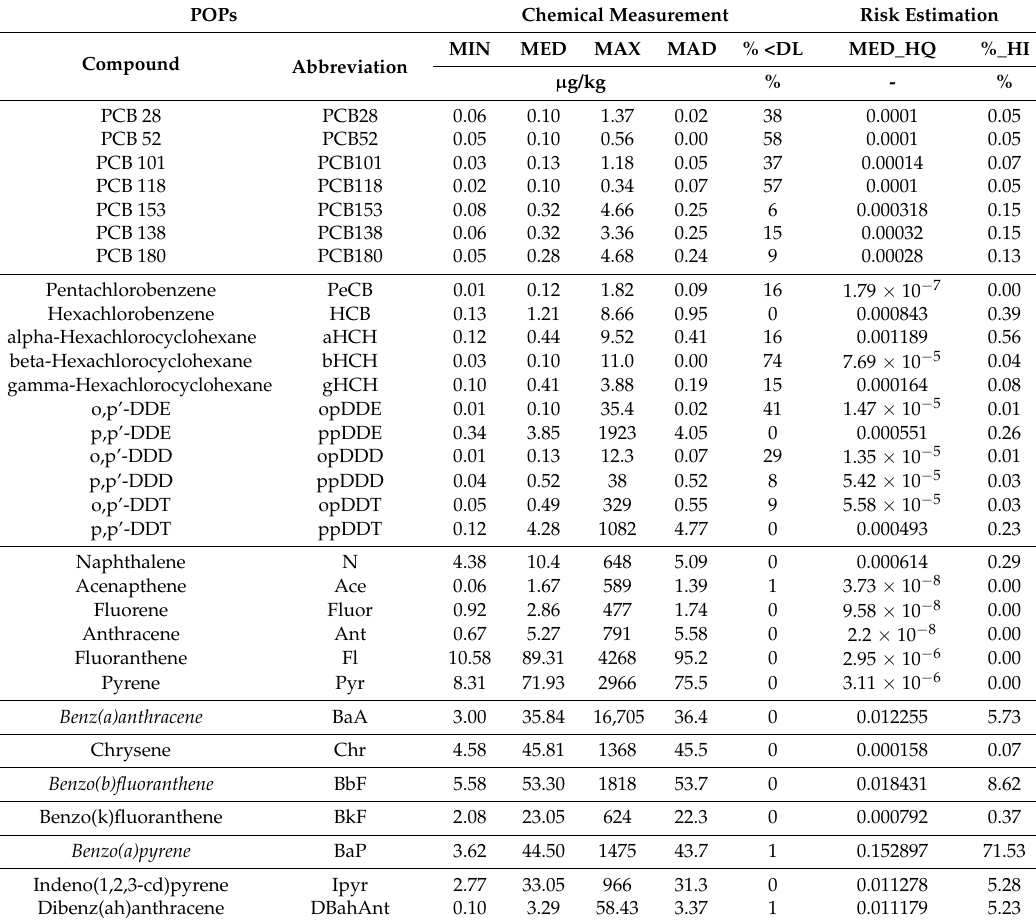
Table 3. Summary statistics for the chemical concentrations of persistent organic pollutants (POPs) in the floodplain soil dataset (minimum: MIN; median: MED; maximum: MAX; spread expressed as median absolute deviation (MAD) and percentage of observations below the detection limit (% <DL)) and a summary of the hazard quotient calculation (median (MED_HQ) and its relative proportion to the median of the hazard index